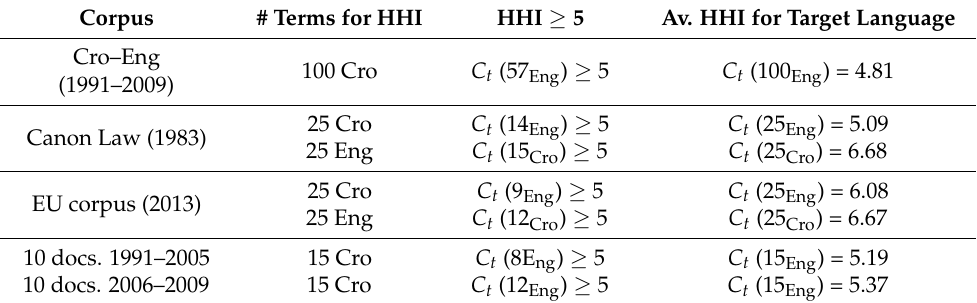
Table 4. Summary of research